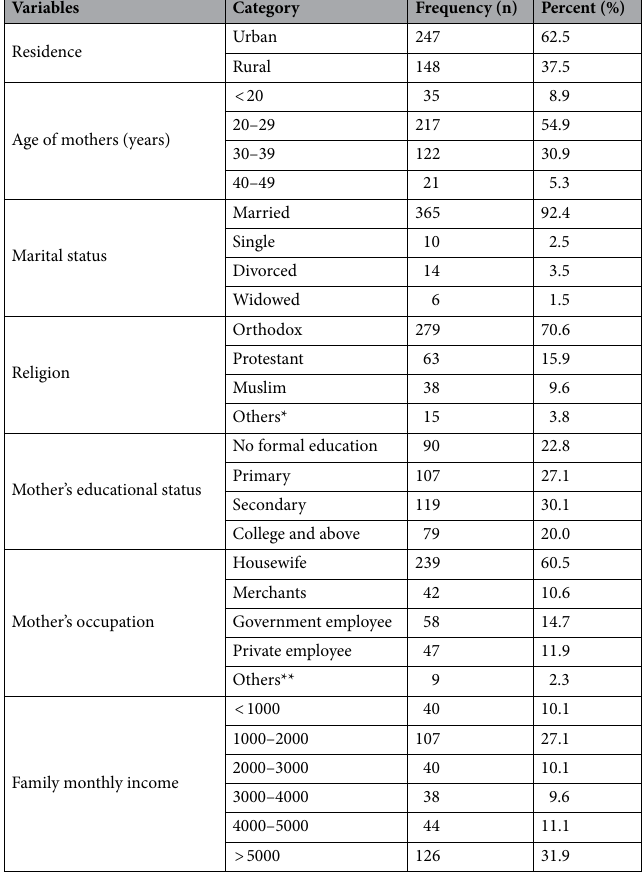
Table 1. Sociodemographic characteristics of respondents in North Shewa zone, Oromia Region, Ethiopia (N = 395). *Catholic, Waqefana. **Students,